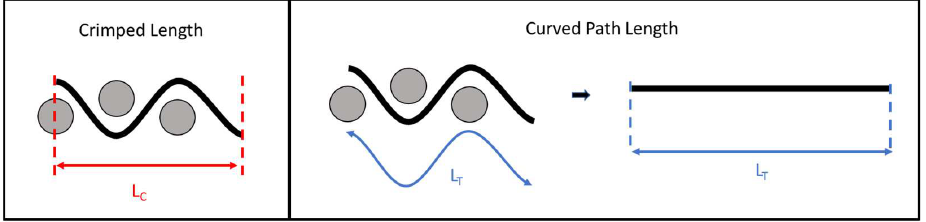
Figure 4. Visual representation of crimped length of yarn (L C ) and curved path length of yarn (L T ).